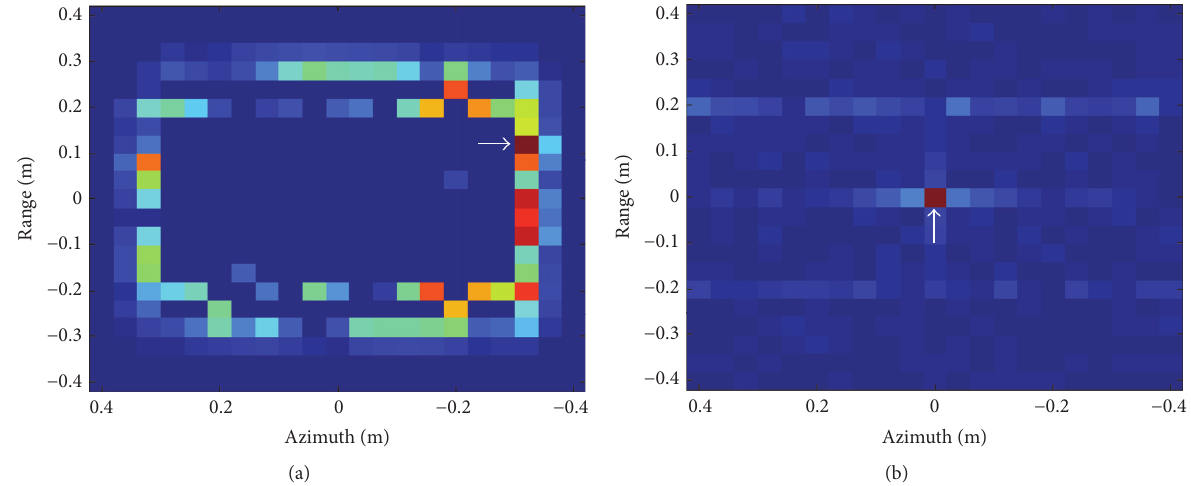
Figure 2: Initial imaging of a vibrating target at ( 0,0 ) by different methods (the arrow points to the maxima and the true maximum is located at ( 0, 0 )): (a) Moore-Penrose pseudoinverse and (b) correlation.